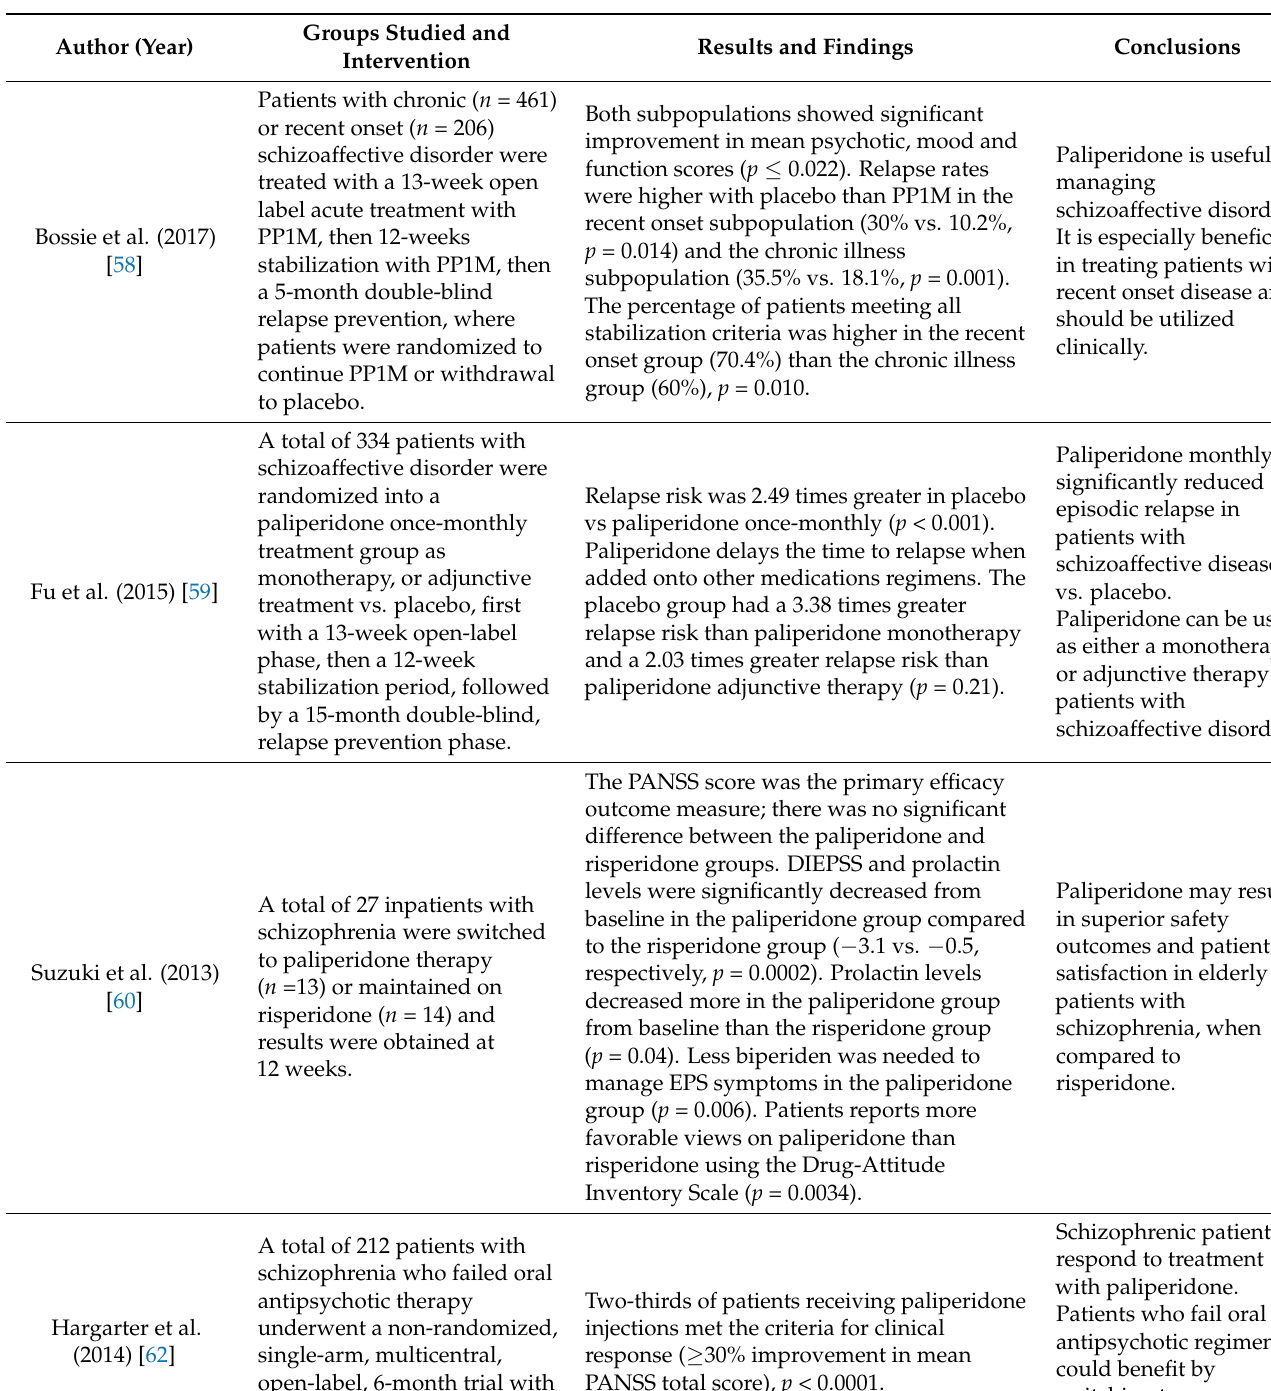
Table 1. Clinical efficacy and